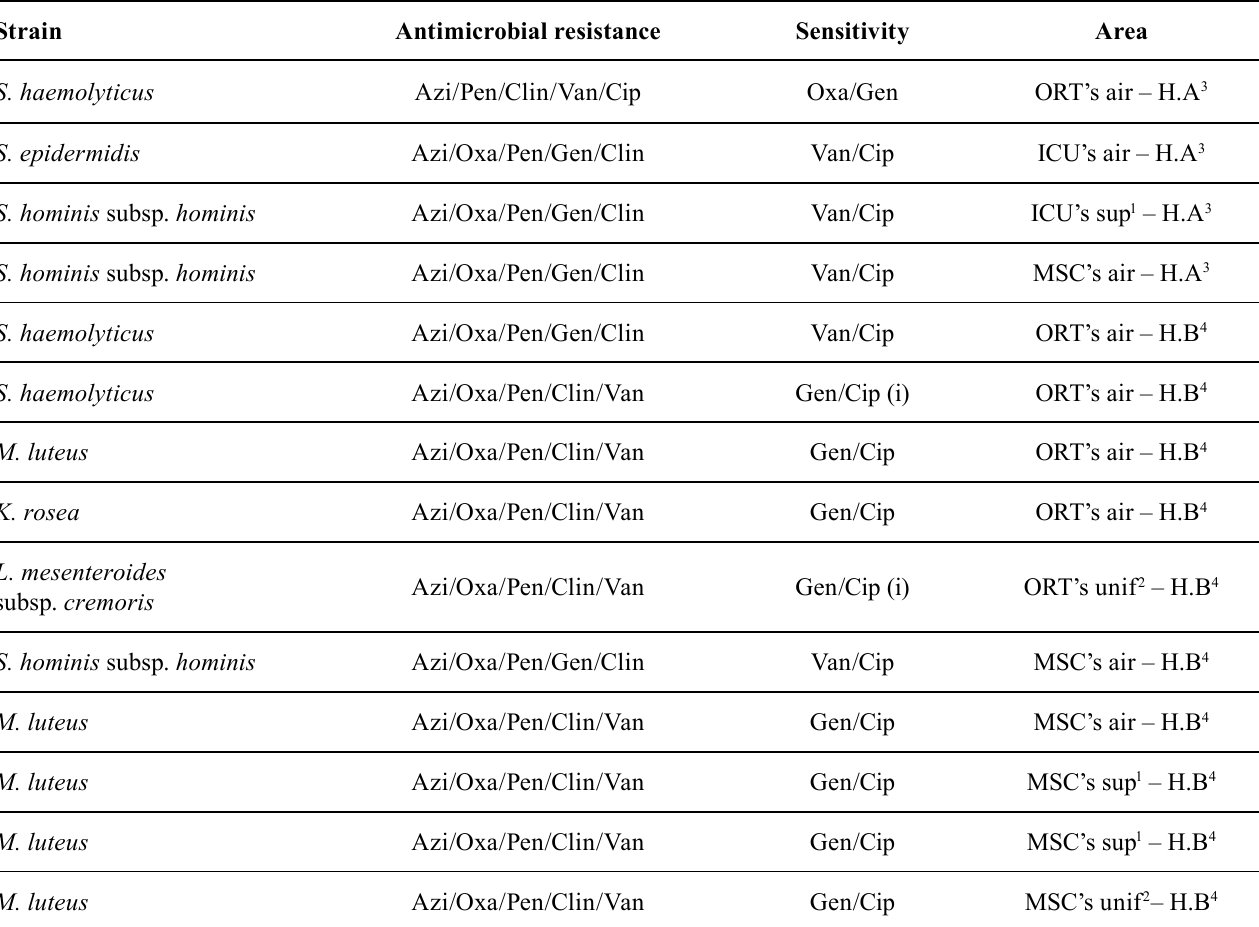
TABLE I – E xtensively drug-resistant bacteria isolated in the evaluated hospitals